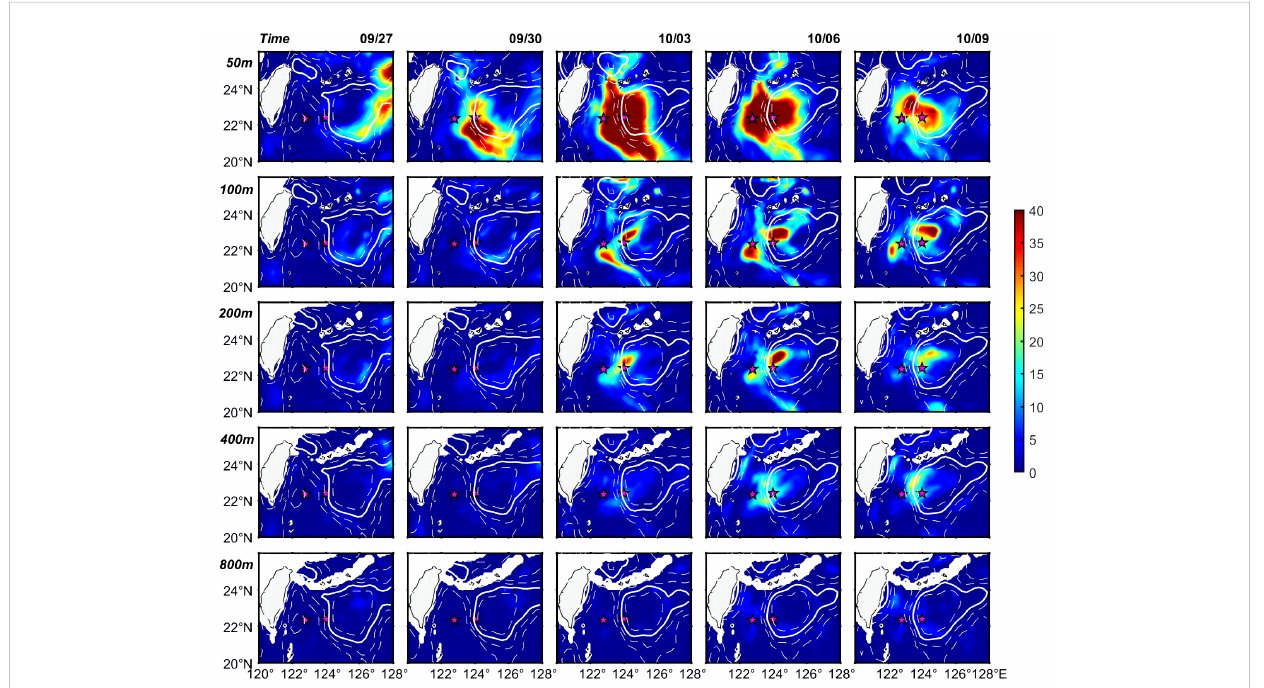
FIGURE 5 Time evolution of NIKE (unit: J/m 3 ) generated by Typhoon MITAG at different depths from 27 September to 9 October. Superimposed white line is the SLA contours with an interval of 0.06 m, and thick white line indicates the 0.18 m contour. Pink stars represent the locations of moorings. The number at the top represents the time of each column, and the depth of each row is marked in bold italics on the far